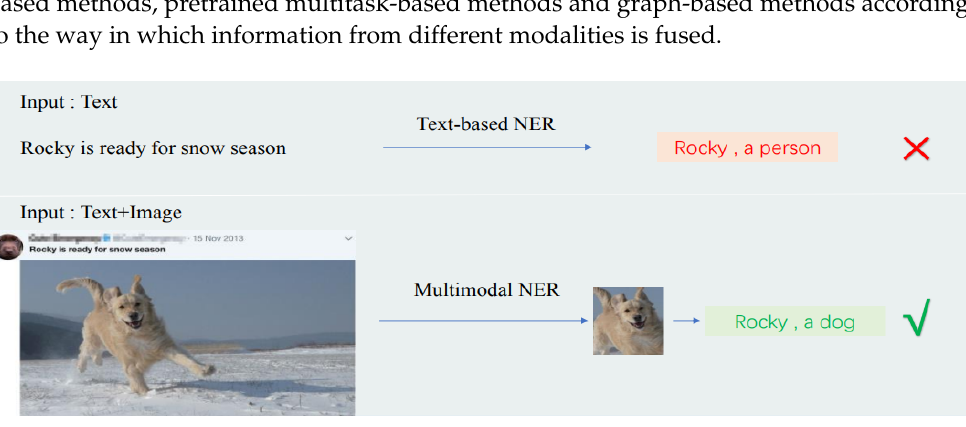
Figure 4. Illustration of multimodal named entity